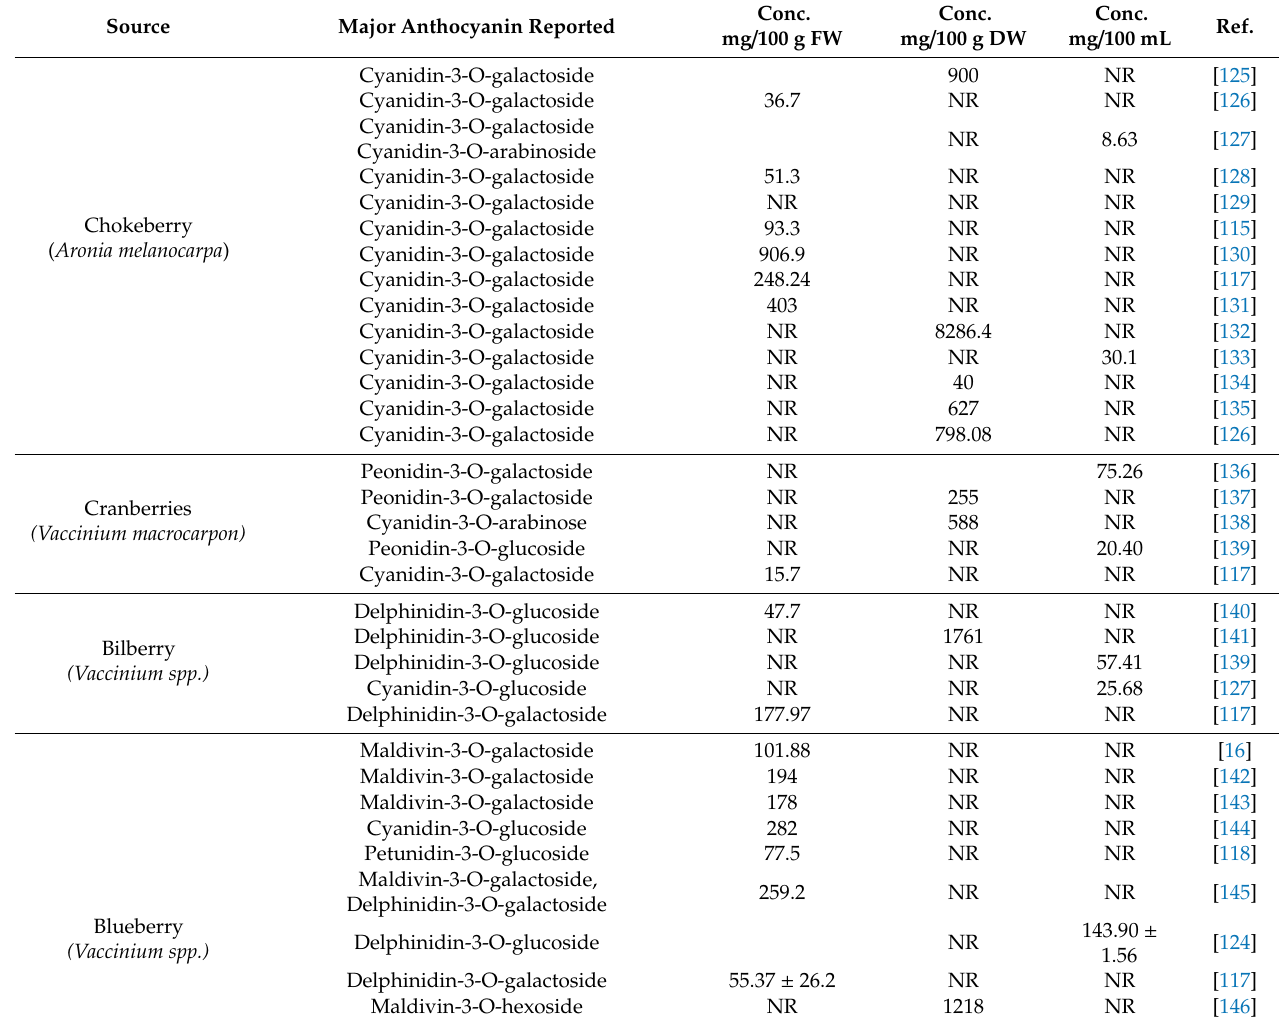
Table 2. Rich anthocyanin sources of fruits and